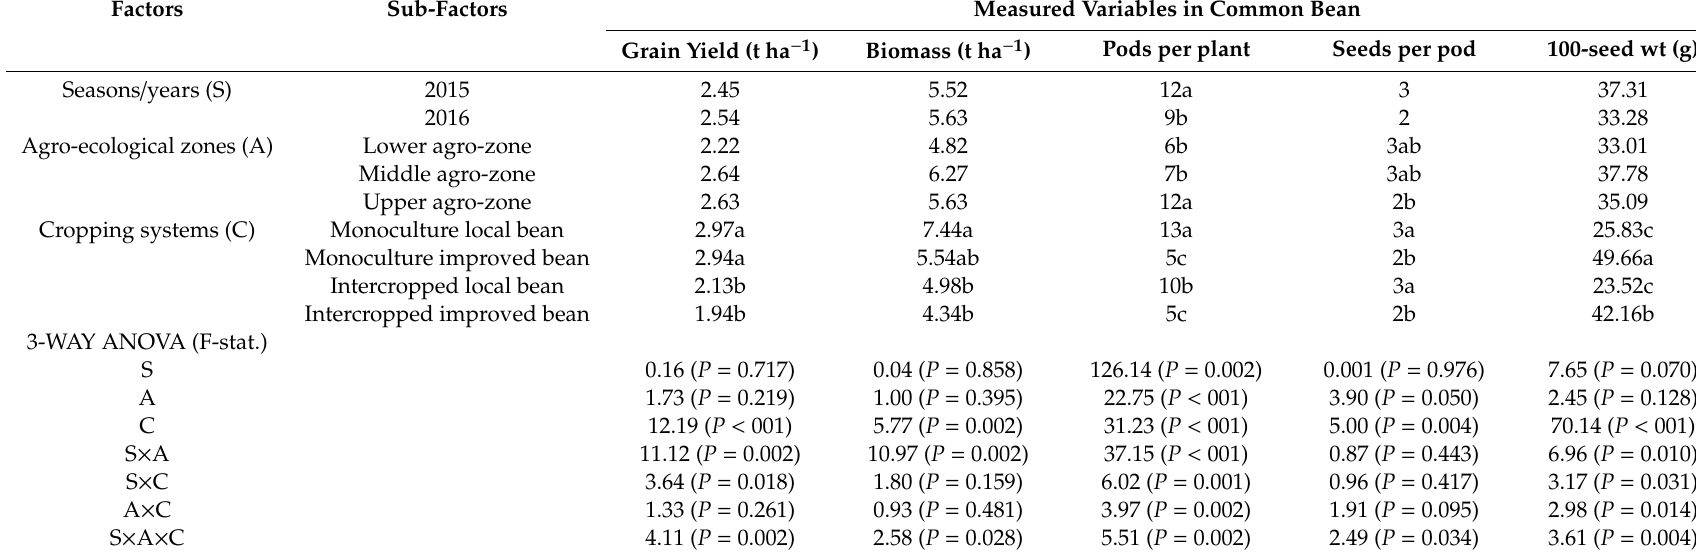
Table 2. Grain yields, total biomass, number of pods per bean plant, number of seeds per pod, and weight of 100-seeds of the common bean as a ff ected by the cropping seasons, agro-ecological zones, cropping systems, and their